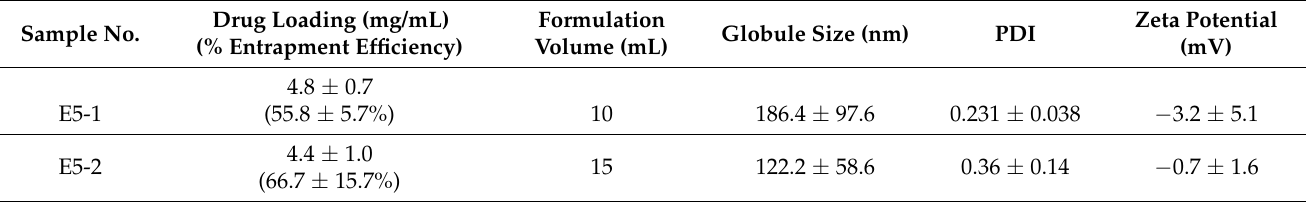
Table 4. Formulation characteristic table for prepared nanoemulsions using hot melt extrusion. Data presented as mean ± SD (n =